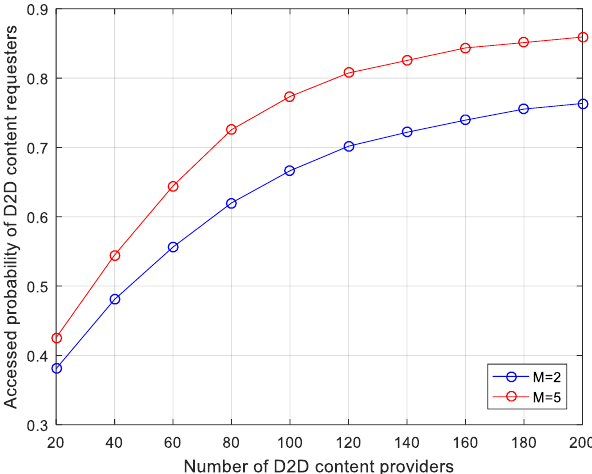
Figure 5. Accessed probability for di ff erent numbers of cellular channels with di ff erent numbers of D2D content providers, N =